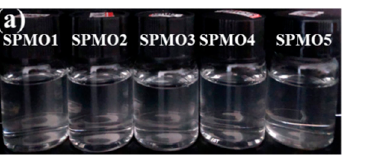
Figure 4. Photos of the triblock copolymers aqueous solutions (1 mg/mL) at ( a ) 25°C and ( b ) 35°C.